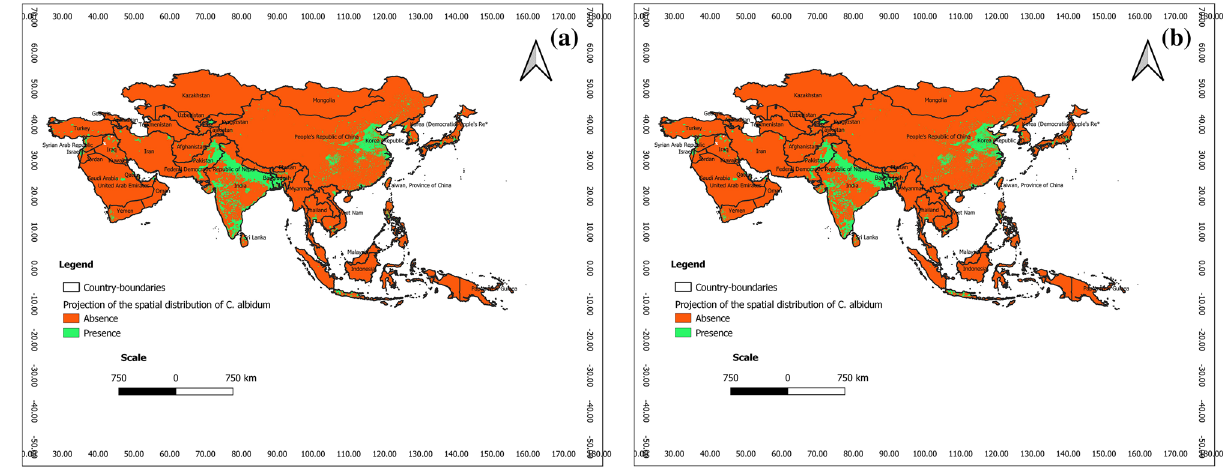
Figure 10. Projections of the spatial distribution of C . albidum according to BRT across Tropical Asia: a) at present; b) at horizon 2060 SSP585 (the maps were generated using R version 4.1.3 (https:// www.R- proje ct. org/), QGIS 3.18.1 (http:// qgis. osgeo. org), and WGS 84 as Coordinate Reference System).